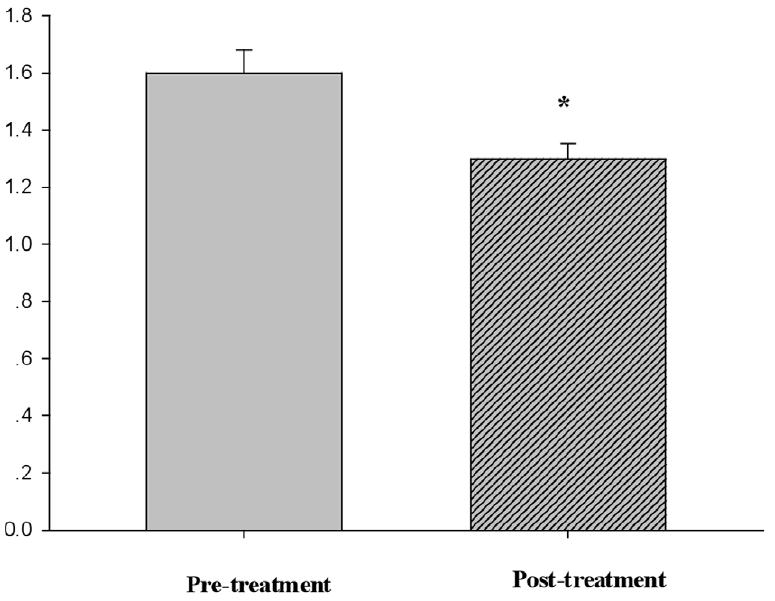
Figure 1. Plasma FGF-21 levels pre- and post-treatment with CSII in 30 nT2DM patients with FBG $ 14.0 mmol/L. * P , 0.05 vs. pre- treatment.